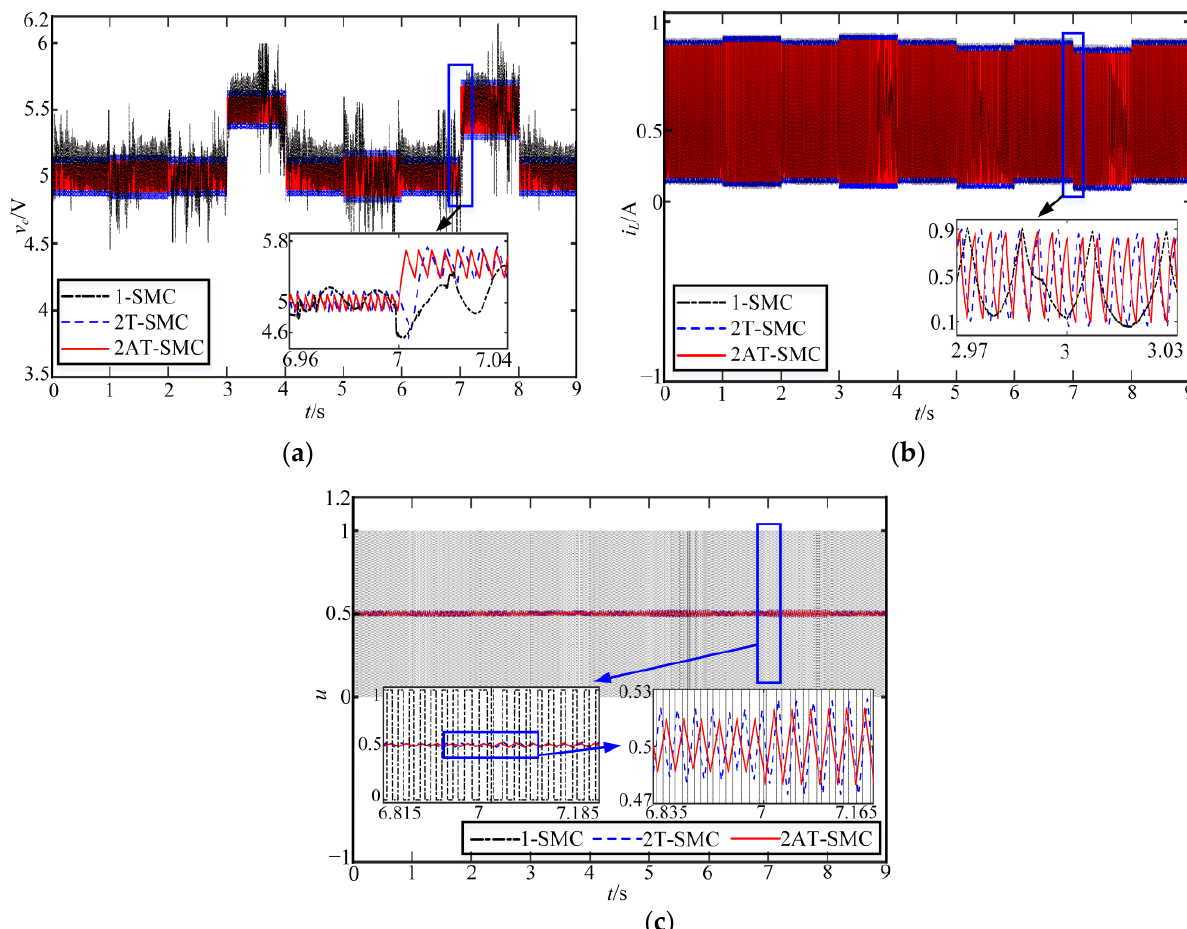
Figure 9. Comparative experimental results: ( a ) Output voltage v c ; ( b ) Inductor current i L ; ( c ) Control